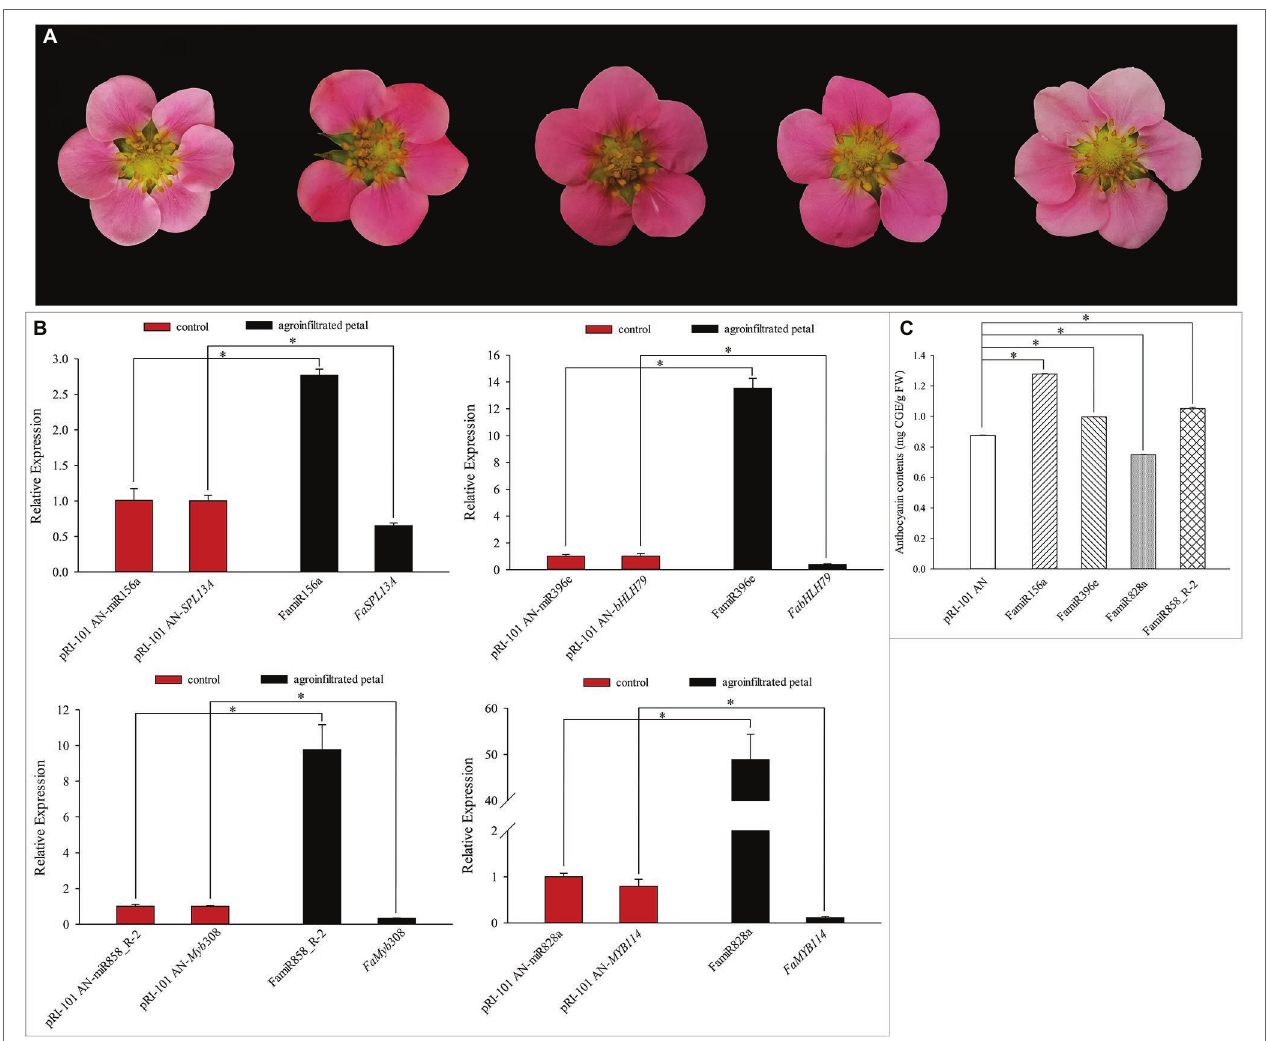
FIGURE 8 | Transient expression of candidate miRNAs in pink-flowered strawberry cultivar “Fenyun.” (A) Petal color after injection. From left to right: the pRI-101 AN (control), pRI-101 AN-FamiR156a, pRI-101 AN-FamiR396e, pRI-101 AN-FamiR858_R-2, and pRI-101 AN-FamiR828a. (B) Expression levels of candidate miRNAs and targets after injection. (C) The anthocyanin contents in petals after injecting candidate miRNAs. The symbol * indicates statistical significance at p <